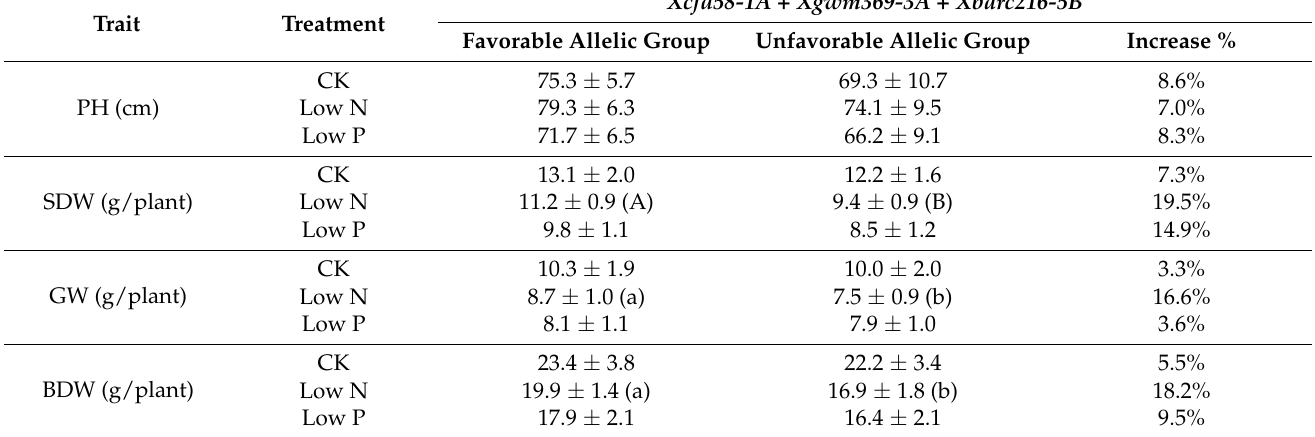
Table 3. Effects of the combination of qRDW-1A, qRDW-3A, and qRDW-5B on wheat yield performance in the field